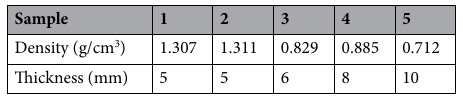
Table 2. Density and thickness for the composites.